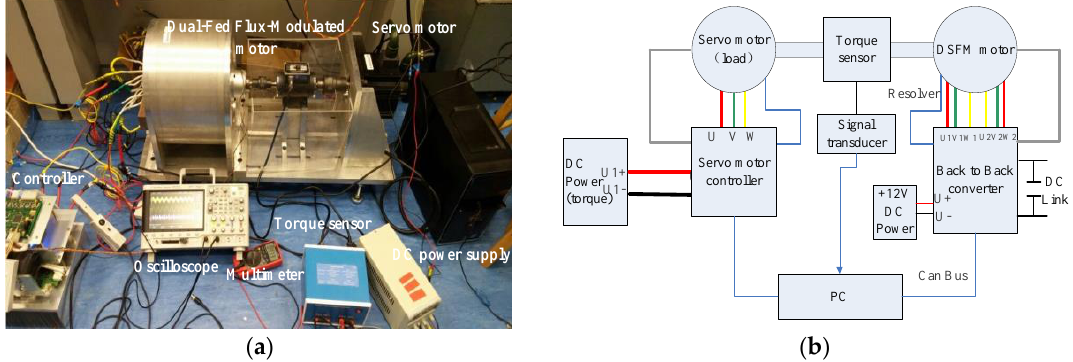
Figure 10. Experimental environment of the DSFM motor: ( a ) laboratory test facility; and ( b ) block diagram of the DSFM motor experimental setup.